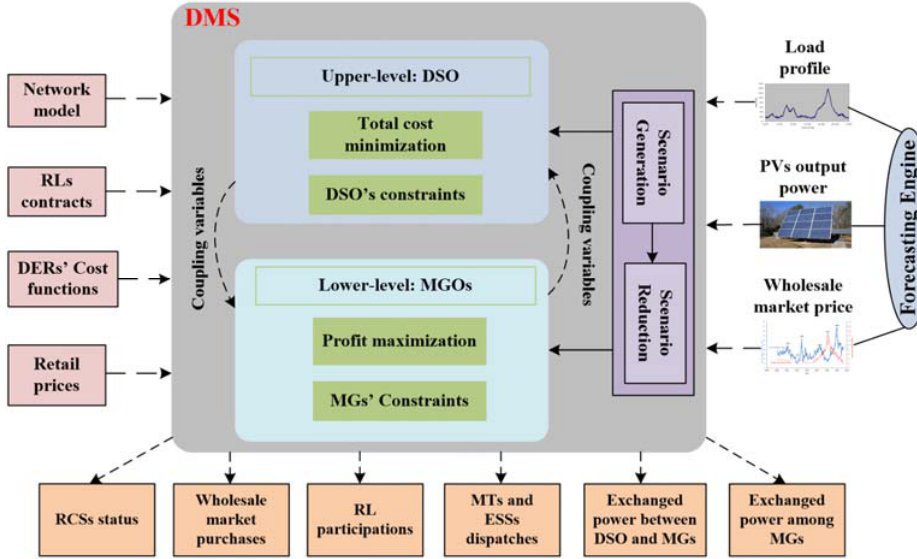
Figure 1. Framework of the proposed bi-level Distribution Management System (DMS).